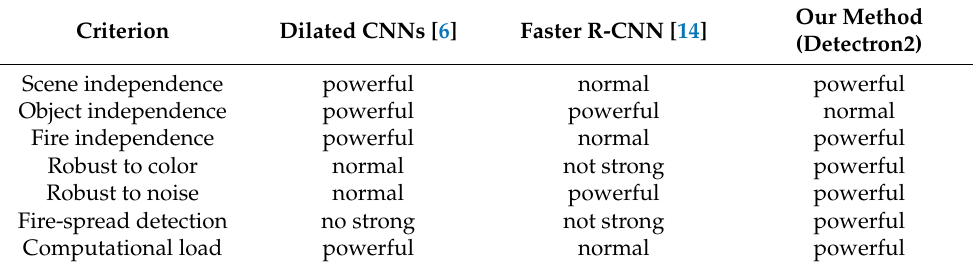
Table 8. Forest fire detection performance comparison using various